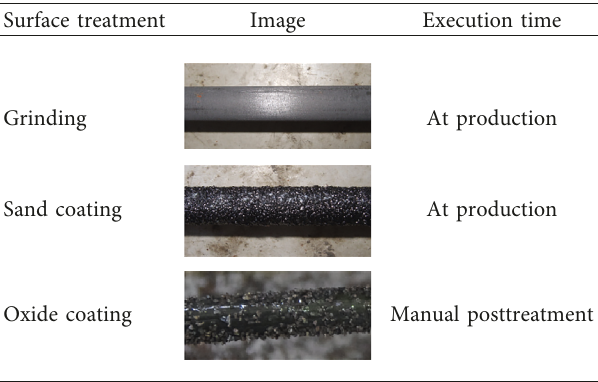
Table 6: Surface treatment of FRP. Surface